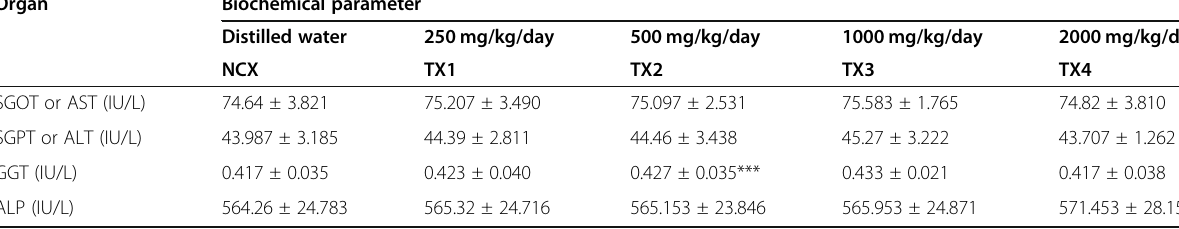
Table 6 Effect of polyherbal combination (PHC) on biochemical parameter Organ